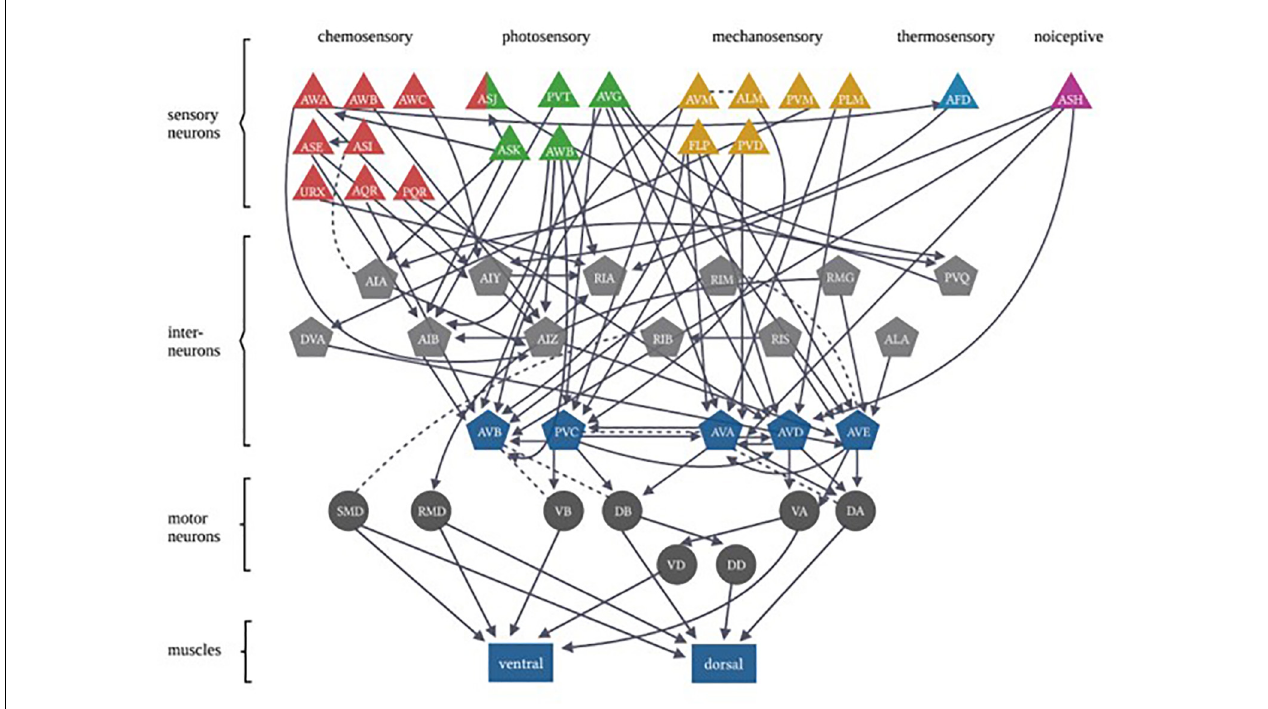
FIGURE 1 | Caenorhabditis elegans photo- and mechanosensory neural circuits are embedded within a broader set of multiple sensory-response circuits. Sensory neurons are represented by triangles, with colors differentiating between different sensory inputs. Gray pentagons represent interneurons and blue pentagons represent command interneurons. Motor neurons are indicated by circles that extend connections to body-wall muscles represented by rectangles (Figure adapted from Fang-Yen et al. (2015), with permission from the Royal Society, United Kingdom).